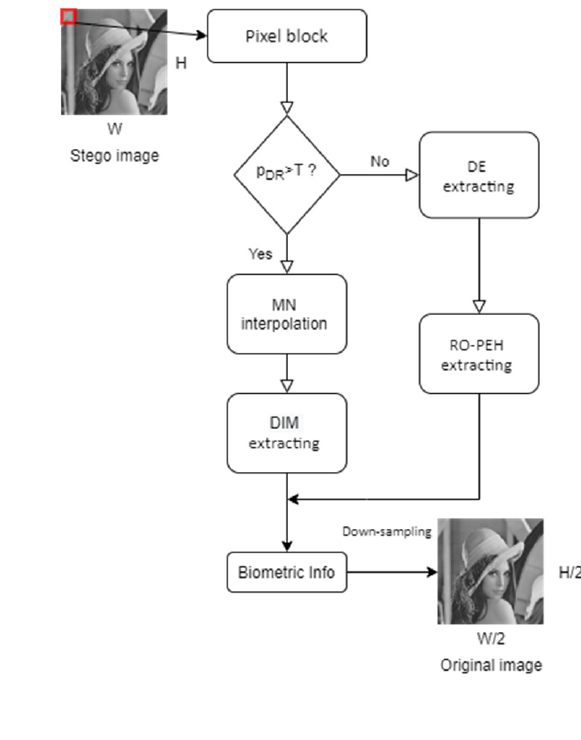
Figure 5. Flowcharts of the embedding and the extraction stages; ( a ) Flowchart of the embedding stage; ( b ) Flowchart of the extraction stage.